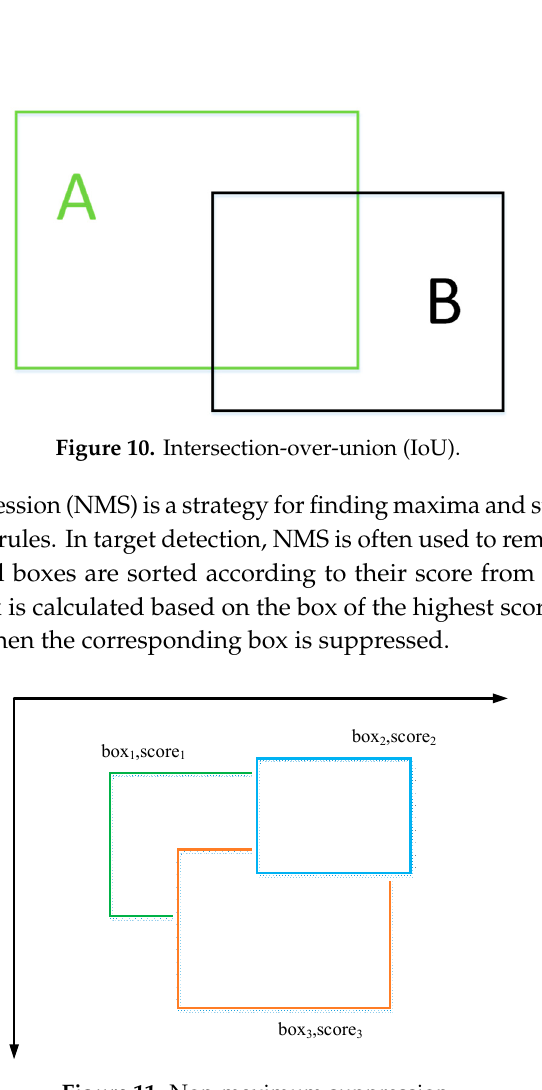
Figure 11. Non-maximum suppression.